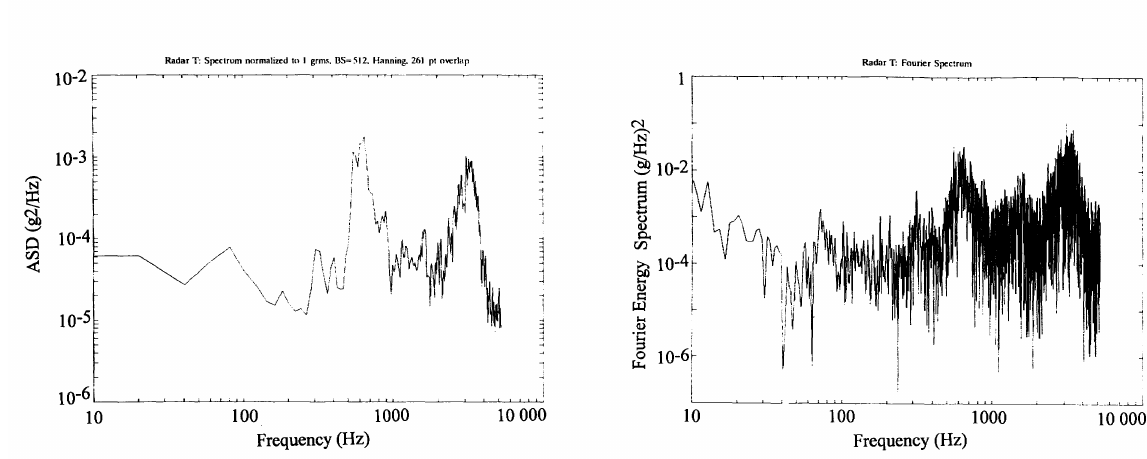
FIGURE 9 Fourier energy spectrum of the time his tory of Fig.